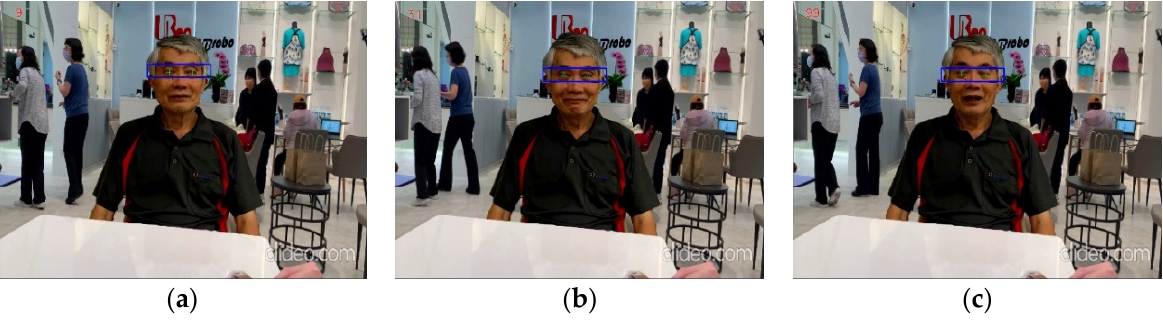
Figure 22. Representative eye gazing recognition results from the video of an elderly man: ( a ) Frame 9 (gazing to the left); ( b ) Frame 31 (gazing at the center); ( c ) Frame 99 (eyes closing).